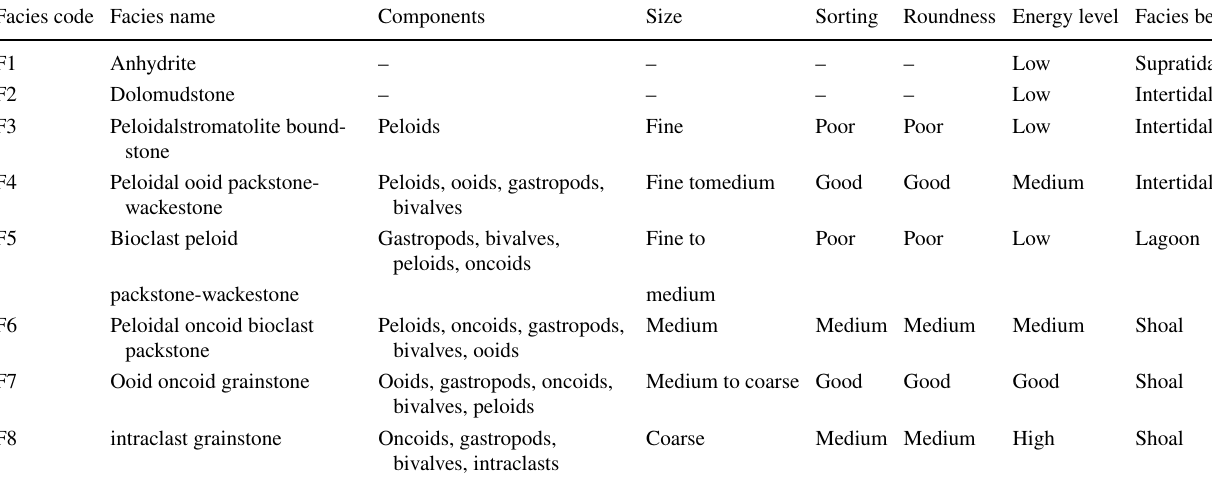
Table 1 Main facies and their properties of the Arab Formation in the studied area Facies code Facies